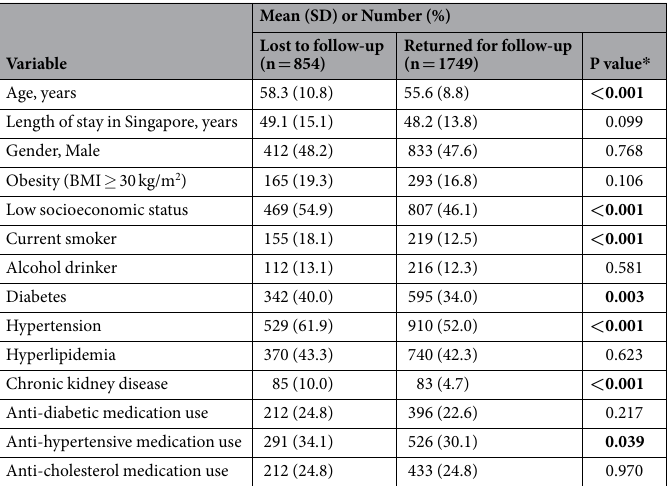
Table 2. Comparison of baseline characteristics of participants by follow-up status. * Mann-Whitney U test or chi-squared test. Low socioeconomic status was defined as primary or lower education, and individual monthly income < SGD2000. Bolded values indicate statistically significant